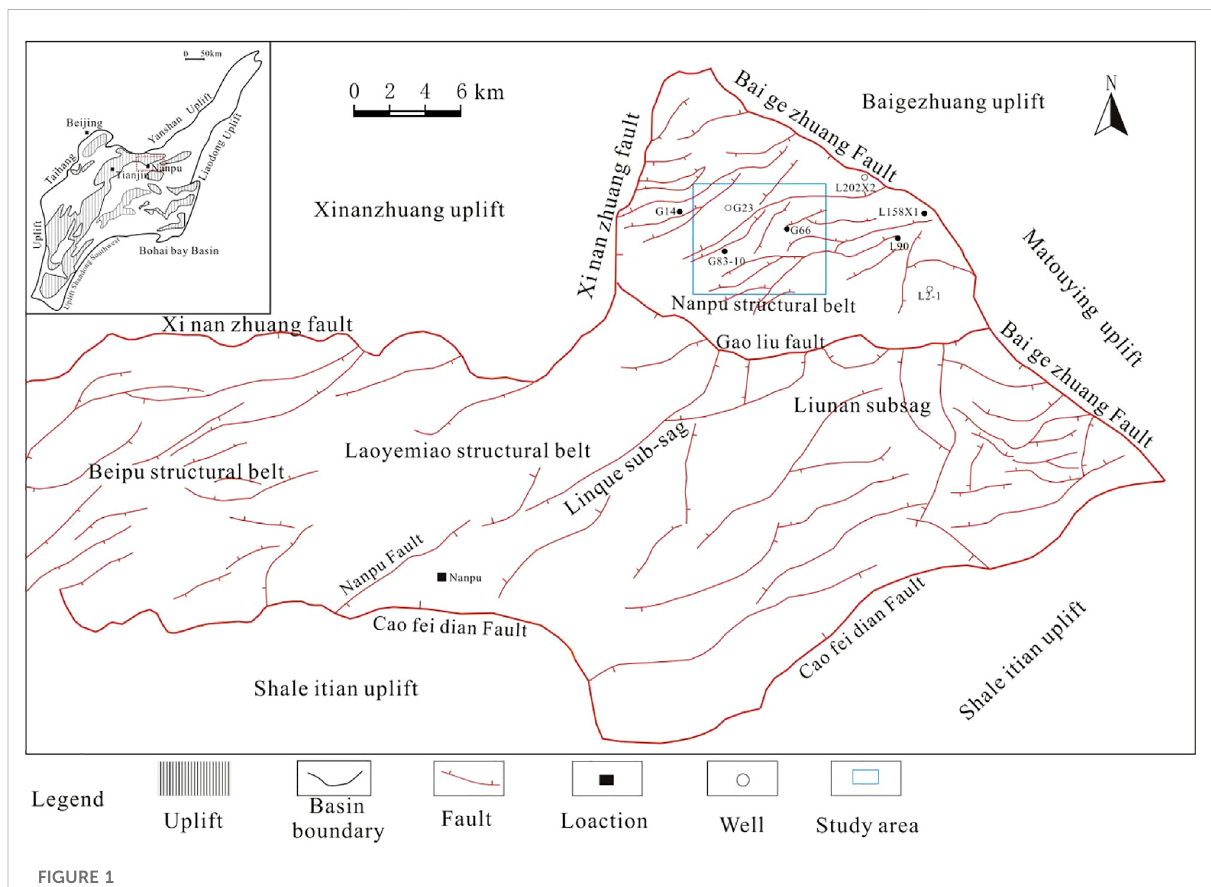
FIGURE 1 Structure location and well location map of the Gaoshangpu oil fi